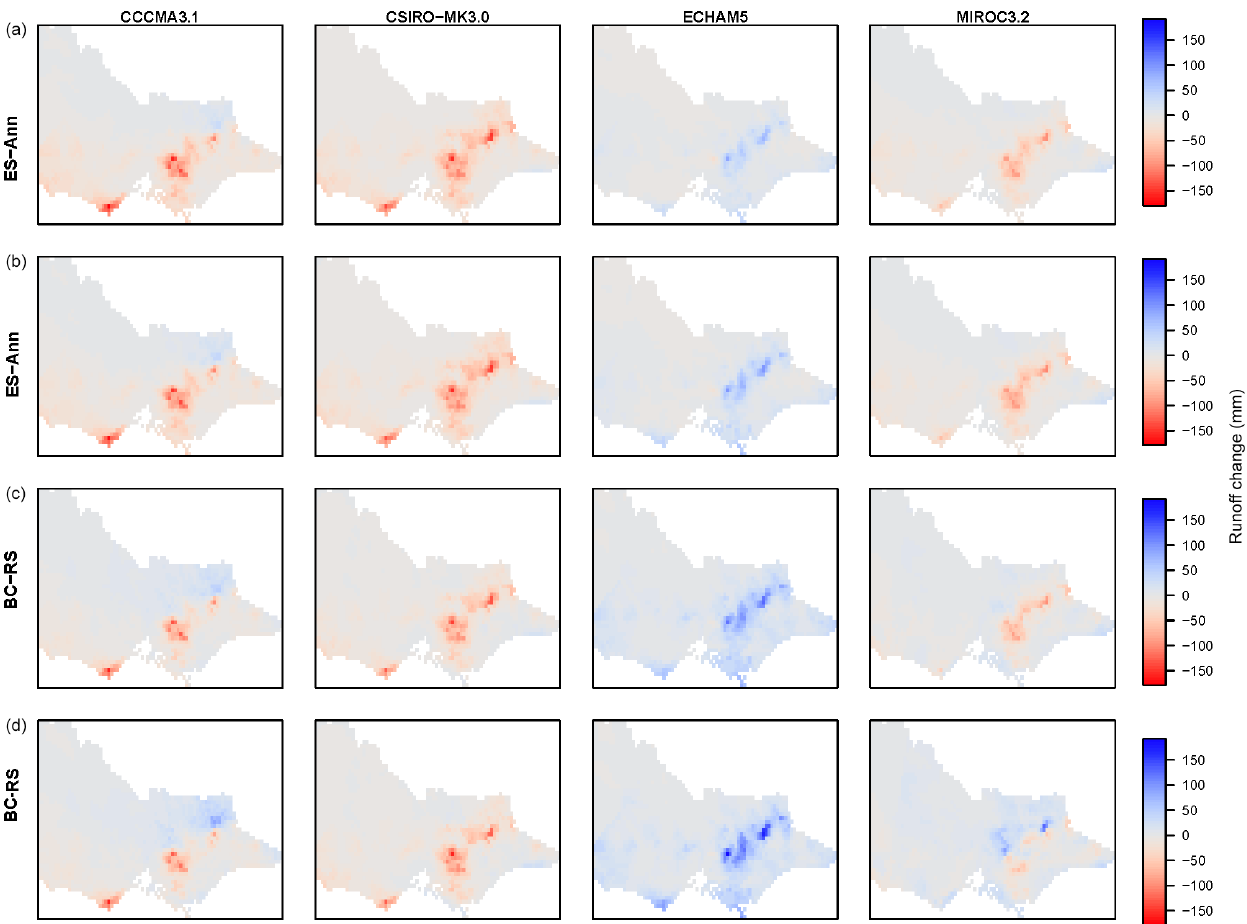
Figure 5. Mean annual runoff change (mm, future minus historical) for (a) ES-ann, (b) ES-seaann, (c) BC RS and (d) BC. Columns (left to right) show CCCMA3.1, CSIRO-MK3.0, ECHAM5 and